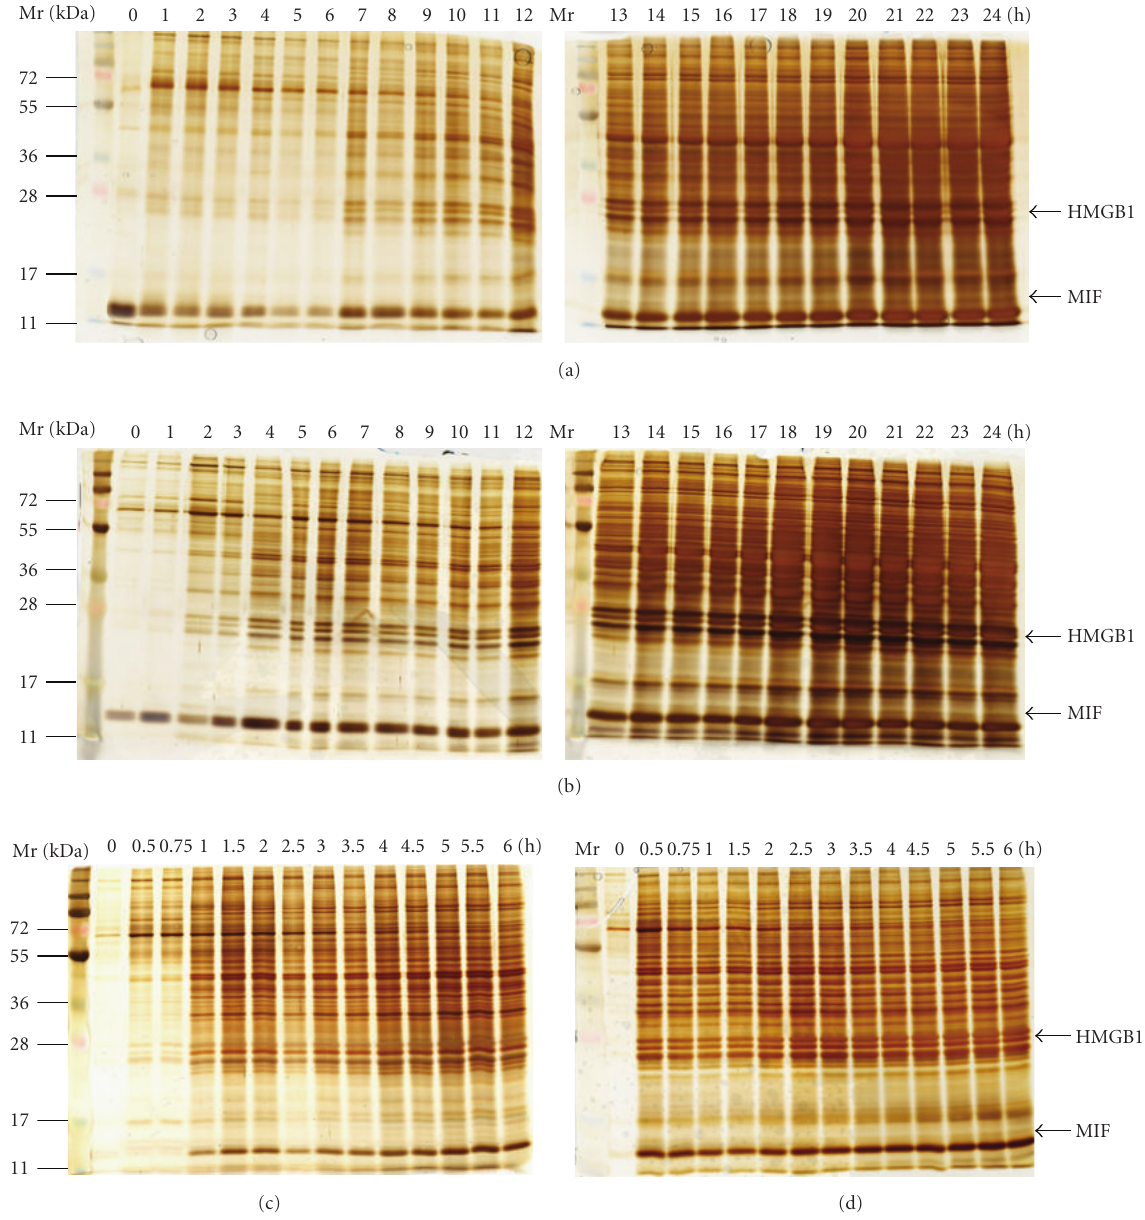
Figure 1: Release of proteins during ischemic storage of liver. Release of proteins into the e ffl uent collected at defined intervals within after 24h cold ischemia or 6h warm ischemia was visualized by silver staining after electrophoresis. The concentration of total protein increased substantially within the first 30/60min of warm/cold ischemia. Arrows indicated the positions of HMGB1 and MIF. (a) Cold ischemia; (b) mechanical stress plus cold ischemia; (c) warm ischemia, (d) mechanical stress plus warm